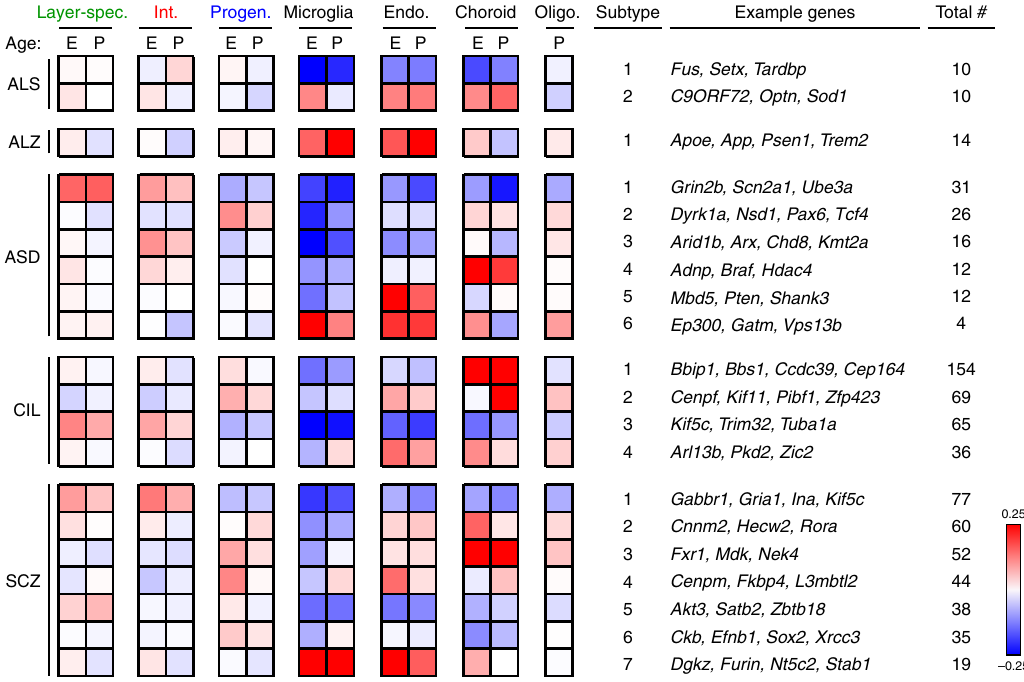
Drop-seq procedure . Drop-seq was performed largely as described 11 . Brie fl y, cortical cells were diluted to an estimated concentration of 400 cells µL − 1 in Ca 2 + and Mg 2 + free HBSS with ion channel inhibitors and HEK293T cells were spiked in at a concentration of 3% of total cells (12 cells µL − 1 ) while barcoded beads (ChemGenes Corporation, catalogue number Macosko201110) were resuspended in lysis buffer to an estimated concentration of 400 beads µL − 1 . Cells and beads were co-encapsulated with oil (QX200 ™ Droplet Generation Oil for EvaGreen, Biorad) using a micro fl uidics chip (Part number 3200455, Dolomite). Droplets of around 3mL of aqueous volume (1.5mL of cells and beads) were broken with per fl uorooctanol in 30mL of 6× SSC. The harvested beads were then washed twice with 6× SSC and hybridized RNA was reverse transcribed using Maxima H minus Reverse Transcriptase (ThermoFisher). Populations of 2500 reverse-transcribed beads (~100 cells) were separately ampli fi ed with 13 cycles of PCR (primers, chemistry, and cycle conditions identical to those previously described) and PCR products were puri fi ed with 0.6× AMPure XP beads (Agencourt). cDNA from an estimated 12,000 E14.5 cells and 8000 P0 cells were pooled, puri fi ed and tagmented with Nextera XT DNA Library Preparation kit (Illumina).